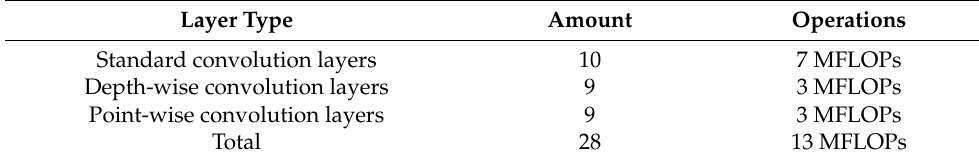
Table 1. The MobileNetV2 model characteristics in terms of computational complexity.